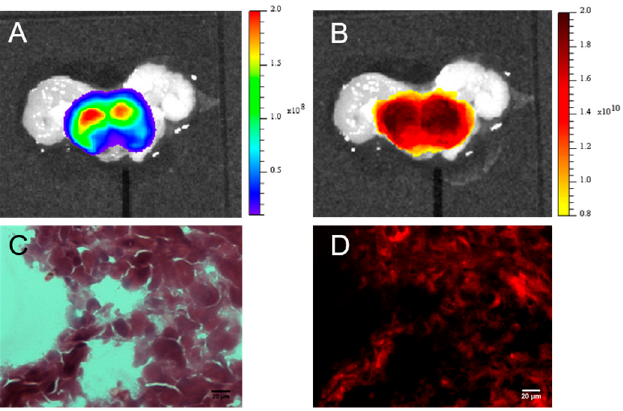
Figure 3. Ex vivo imaging and histology of LipImage TM 815 accumulation in prostate tumors. Prostates were excised and imaged ( A ) by BLI and ( B ) by FRI; ( C ) HES coloration revealed tumor cells and ( D ) epifluorescence revealed fluorescent signals from LipImage TM 815 in prostate cancer cryosection.